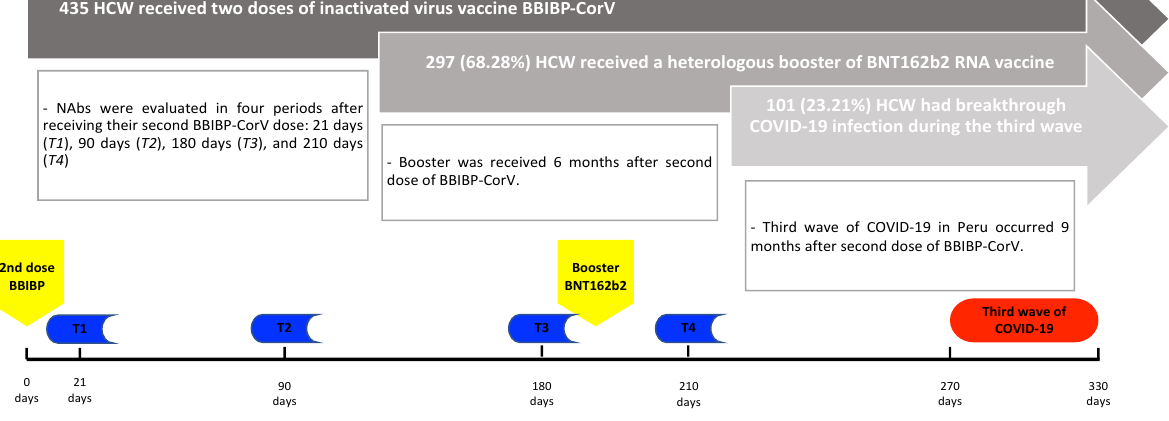
Figure 1. Timeline of the serological evaluations according to the vaccination and third COVID-19 wave period.